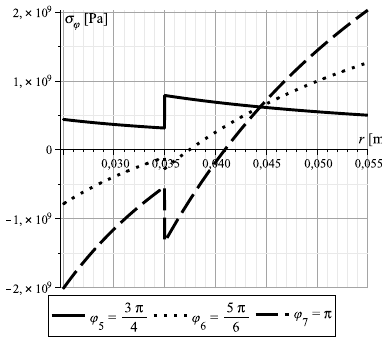
Figure 25: Plot of ϕ ( φ ) (Example 5.3).